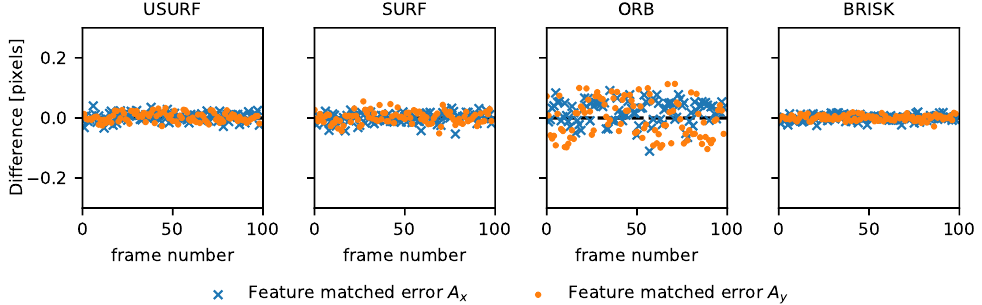
Figure 3. Difference between experimental speckle velocimetry data processed using the normalised cross-correlation (NCC) and each of the feature tracking methods. Here the crosses and dots represent the x and y components,